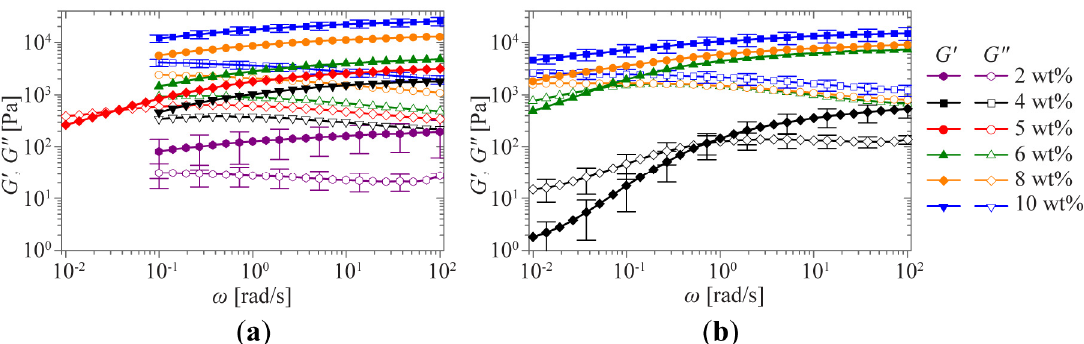
Figure 3. Oscillatory rheological measurements. Frequency sweeps for 1a ( a ) and 1b ( b ) at concentrations ranging from 2 and 4 to 10 wt %. Error bars shown on the curves for the highest and lowest concentrations indicate a typical experimental error, as quantified by the standard deviations of several independent measurements on the